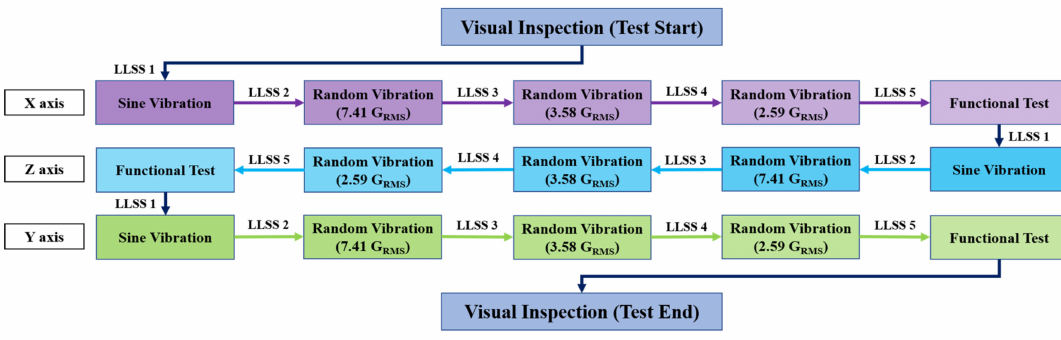
Figure 14. Vibration testing flow